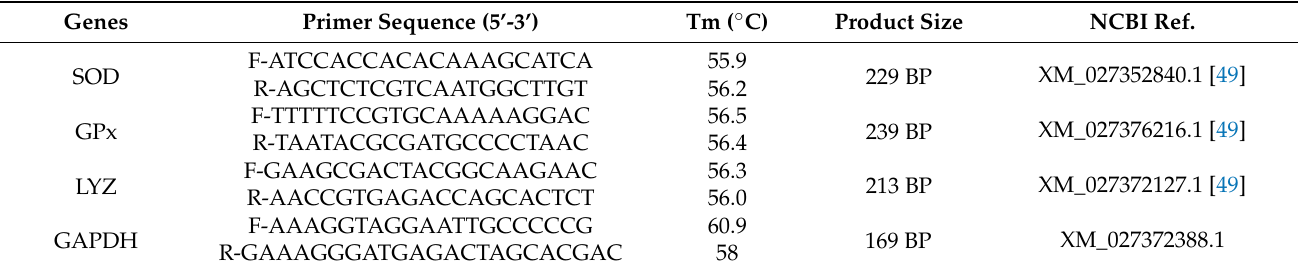
Table 1. Genes and primers for each gene used in RT-qPCR.